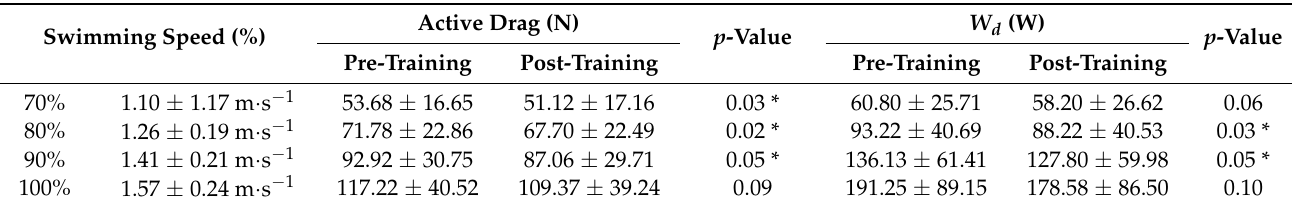
Table 3. Drag and power variables obtained from the measuring active drag system at the pre- and post-training moments (according to the best free-swimming speed percentage).